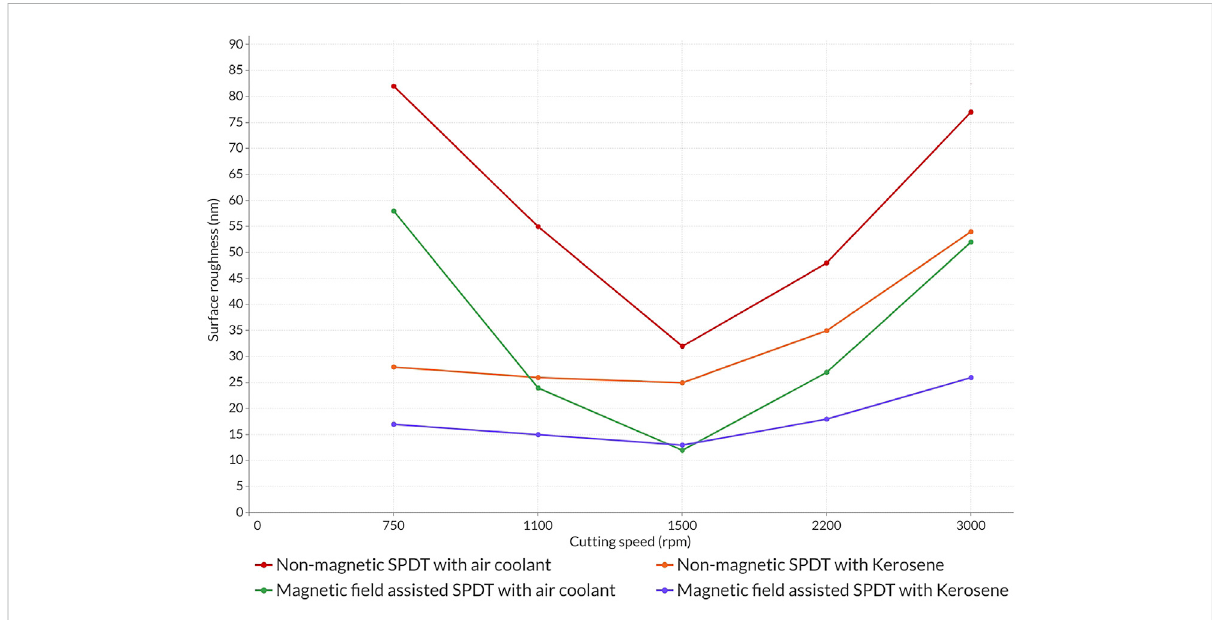
FIGURE 6 Theaveragesurfaceroughnessgeneratedinall machiningseries, with afeedrate of4 mm/minandadepth-of-cutof4 μ m,atdifferentcutting